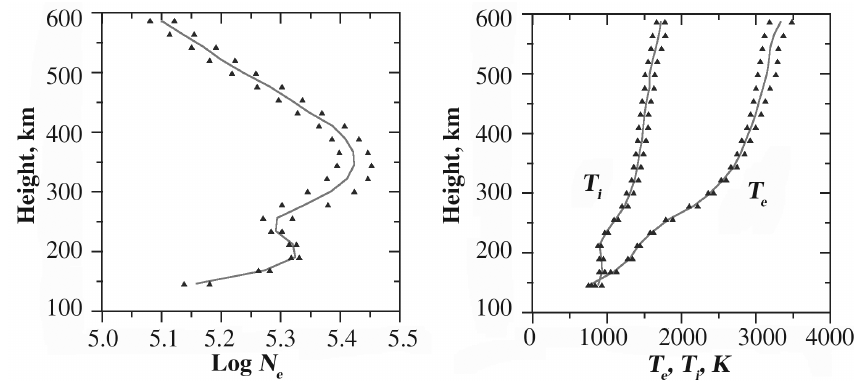
Fig. 4.3. An example of EISCAT observations for a disturbed day of August 05, 1992. Initial median (before polynomial smoothing) profiles calculated over 11:00-12:00 UT time interval are shown. Standard deviations are not experimental, but show the scatter of profiles within the selected 1 h time